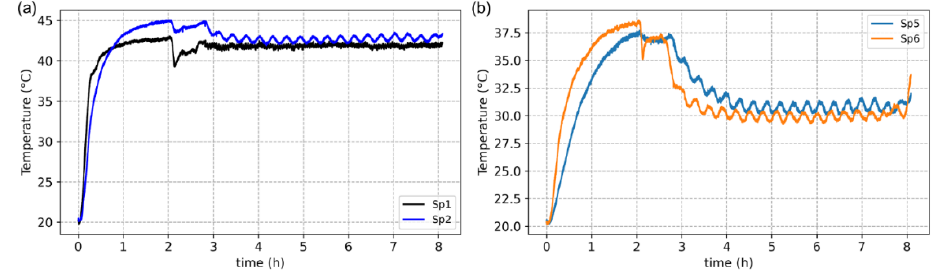
Figure 6. Temperature profiles of ( a ) Sp1 and Sp2, and ( b ) Sp5 and Sp6.